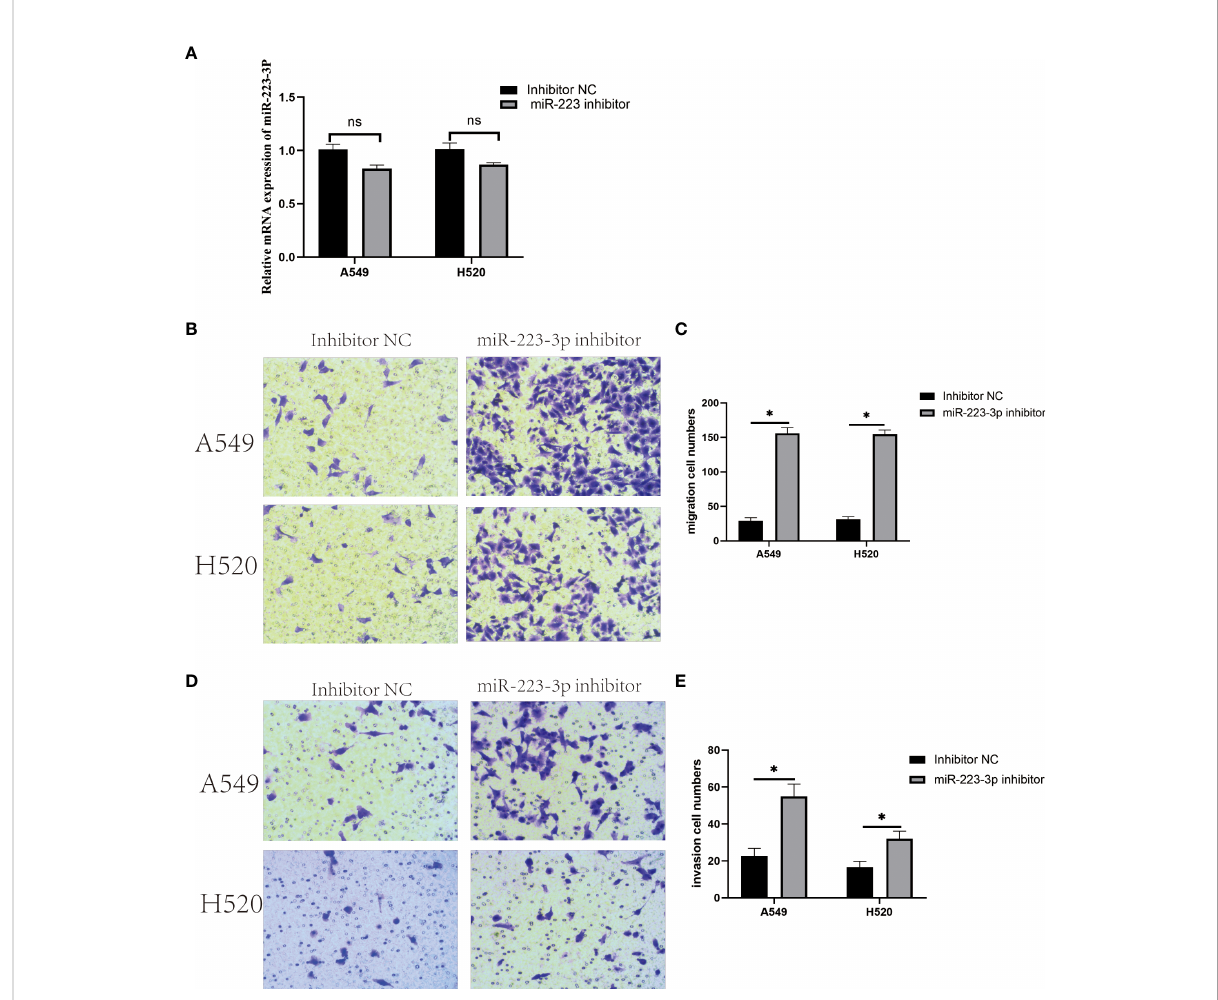
FIGURE 2 Downregulation of miR-223-3p promoted the migration and invasion of A549 and H520 cells. (A) The relative expression of miR-223-3p after miR-223-3p inhibitor transfection was detected by qRT-PCR. (B) Cells at the bottom of the fi lter membrane without Matrigel matrix glue were detected by Transwell assay in high vision fi eld (200×). (C) Quantitative analysis of the migration cells of A549 and H520. (D) Cells at the bottom of the fi lter membrane with Matrigel matrix glue were detected by Transwell assay in high vision fi eld (200×). (E) Quantitative analysis of the invasion cells of A549 and H520. Data were presented as means ± SD of three independent experiments. * P <0.05, ns: no signi fi